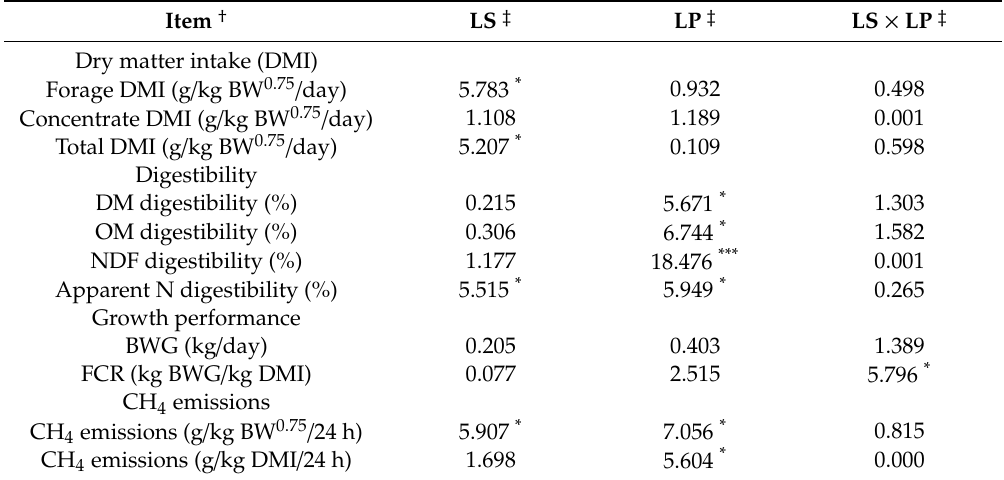
Table 3. A general linear model analysis of legume species (LS), legume proportion (LP), and their interaction effect on feed intake, digestibility, growth performance, and CH 4 emissions (n = 8).